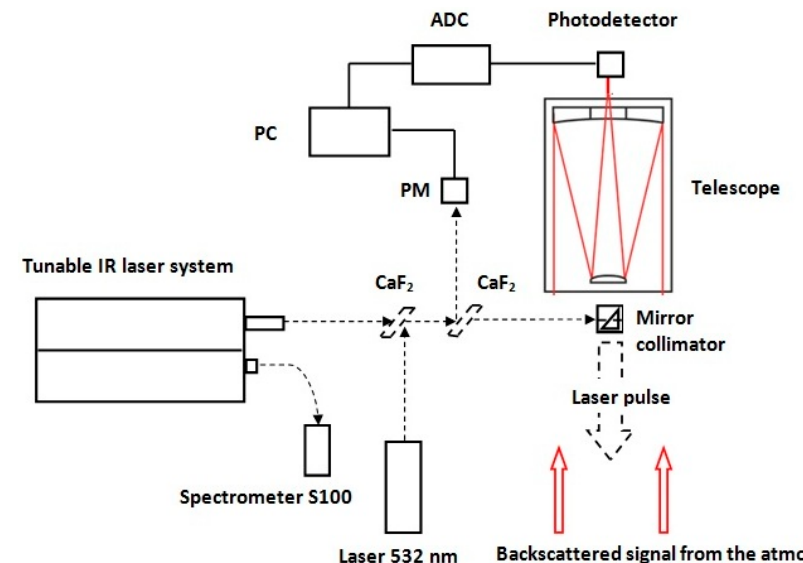
Figure 1. Infrared optical parametric oscillators (IR OPO) lidar system optical scheme.